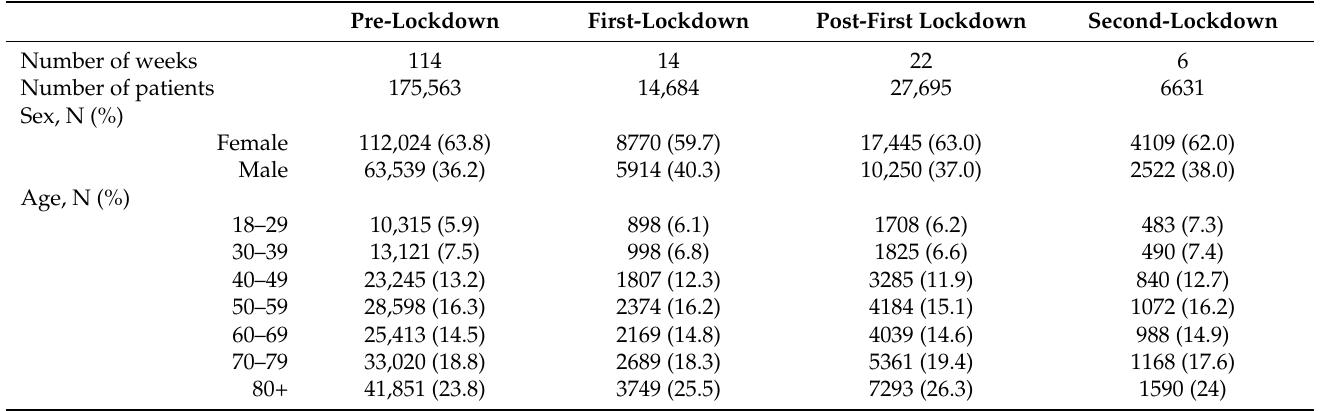
Table 2. Demographic characteristics of incident AD users across different time segments: Pre- Lockdown, First Lockdown, Post-First Lockdown and Second